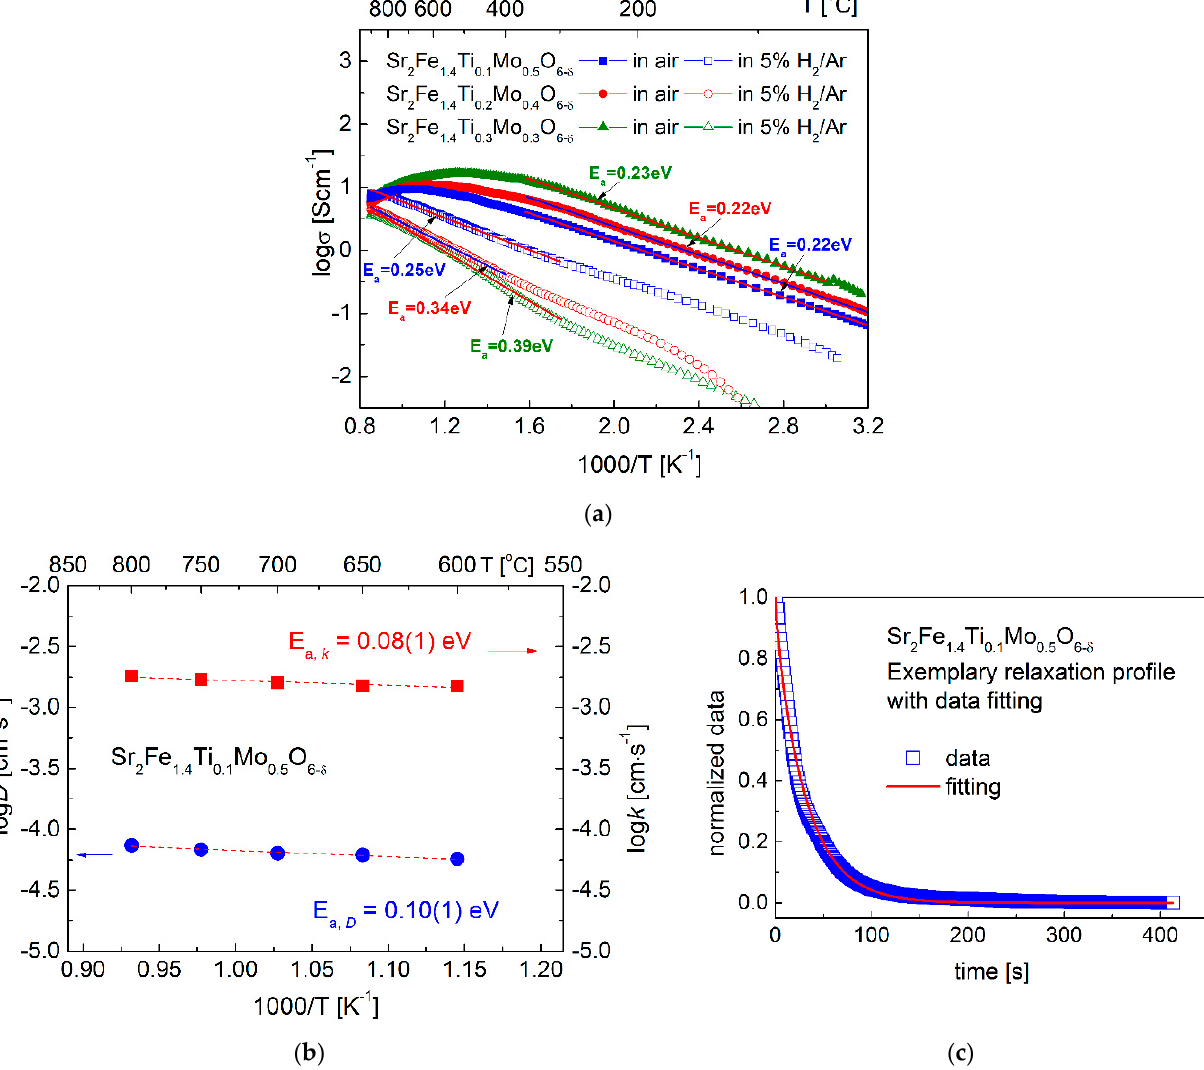
Figure 8. ( a ) Electrical conductivity of Sr 2 Fe 1.4 Ti x Mo 0.6 − x O 6 − δ (x = 0.1, 0.2 and 0.3) oxides in air and 5 vol.% H 2 /Ar; ( b ) transport coefficients D and k determined as a function of temperature for Sr 2 Fe 1.4 Ti 0.1 Mo 0.5 O 6 − δ sample; ( c ) an exemplary normalized relaxation profile with fitting for Sr 2 Fe 1.4 Ti 0.1 Mo 0.5 O 6 − δ